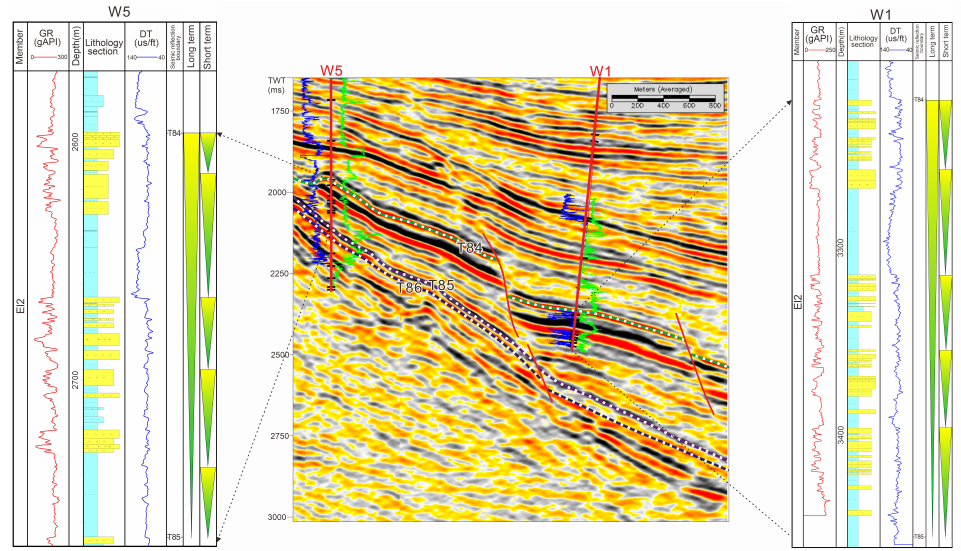
Figure 8. Base level division combined with seismic section of beach-bar sand bodies of Mbr2 stage in the Weixinan sag. The beach-bar sand bodies can be divided into five stages, and two strong and continuous seismic reflections are observed in beach-bar seismic section.